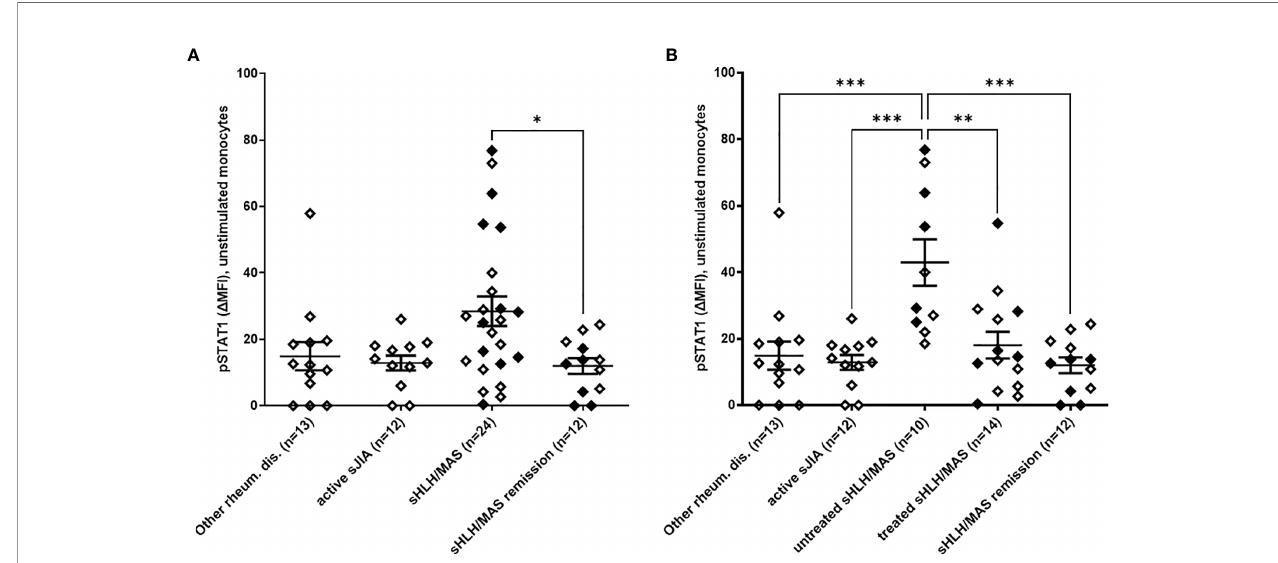
FIGURE 1 | Increased phosphorylated STAT1 (pSTAT1) levels in monocytes of untreated sHLH/MAS patients. (A) pSTAT1 levels were evaluated in unstimulated monocytes from sHLH/MAS patients and compared to levels observed in monocytes from patients with other rheumatic diseases, patients with active sJIA, patients with sHLH/MAS in a remission phase. (B) pSTAT1 levels were evaluated in sHLH/MAS patients not treated (untreated sHLH/MAS) and treated (treated sHLH/MAS) with glucocorticoids at sampling and compared with the other patient groups. Full diamonds indicate samples from MAS patients. (A, B) pSTAT1 levels were measured by fl ow cytometry and reported as Delta mean fl uorescence intensity ( D MFI, calculated by subtracting MFI values of isotype controls from sample MFI values). Differences between groups were analyzed using the one-way ANOVA test and the post hoc Bonferroni ’ s for multiple comparisons test. The data shown represent mean ( ± SEM) values. * p ≤ 0.05, ** p ≤ 0.01, *** p ≤